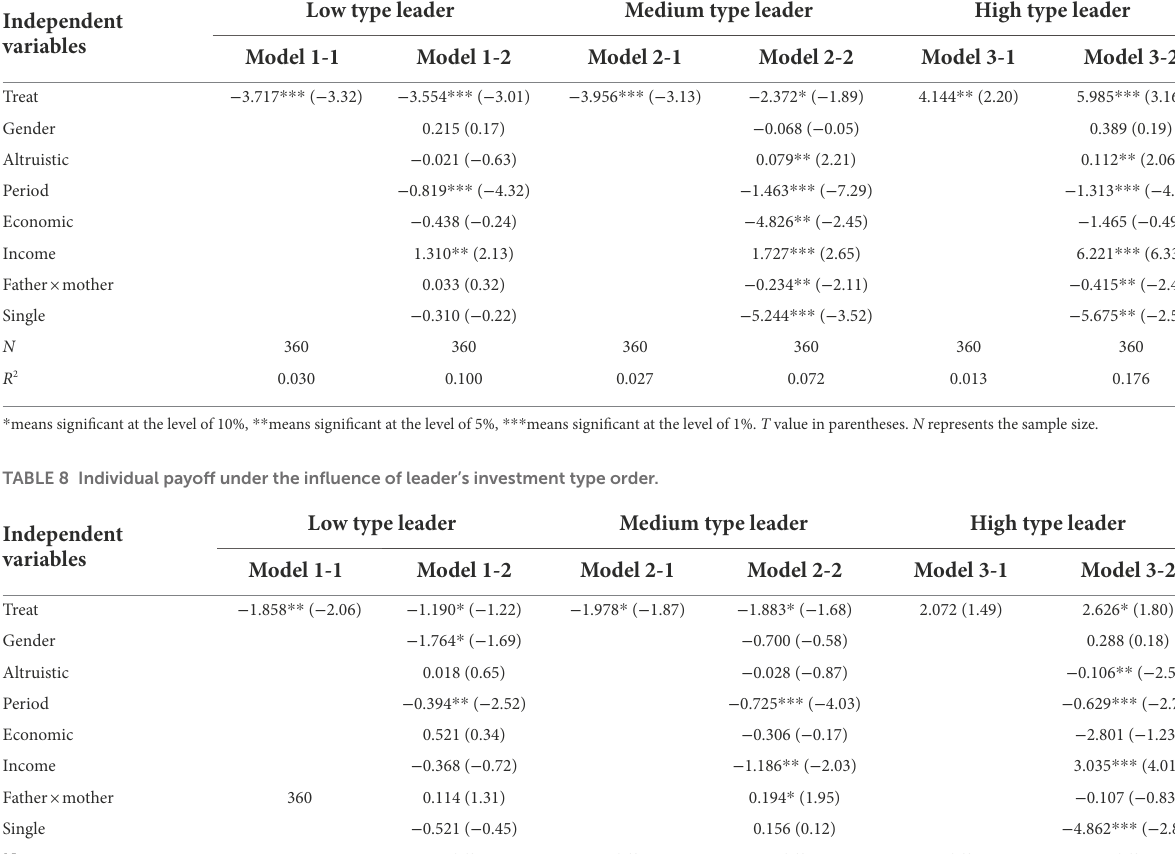
TABLE 7 Individual investment under the influence of leader’s investment type order.